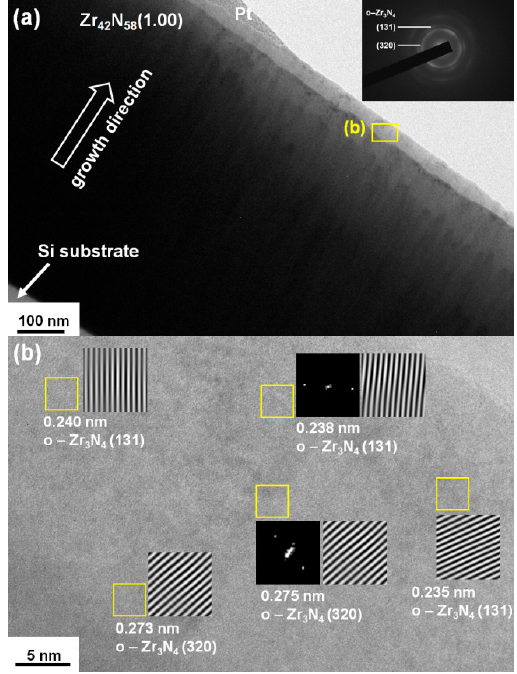
Figure 4. ( a ) Cross-sectional TEM image and SADP, and ( b ) high-resolution image of the Zr 42 N 58 (1.00) films.